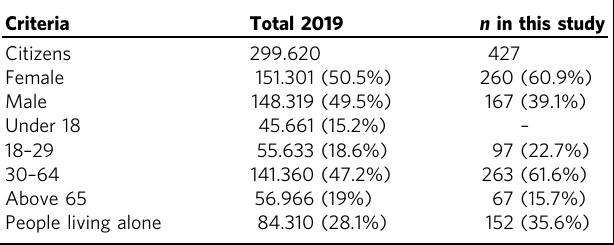
Table 1 Base rate of population and sample size (Source: Statistical Source from Augsburg, Germany, 2020).